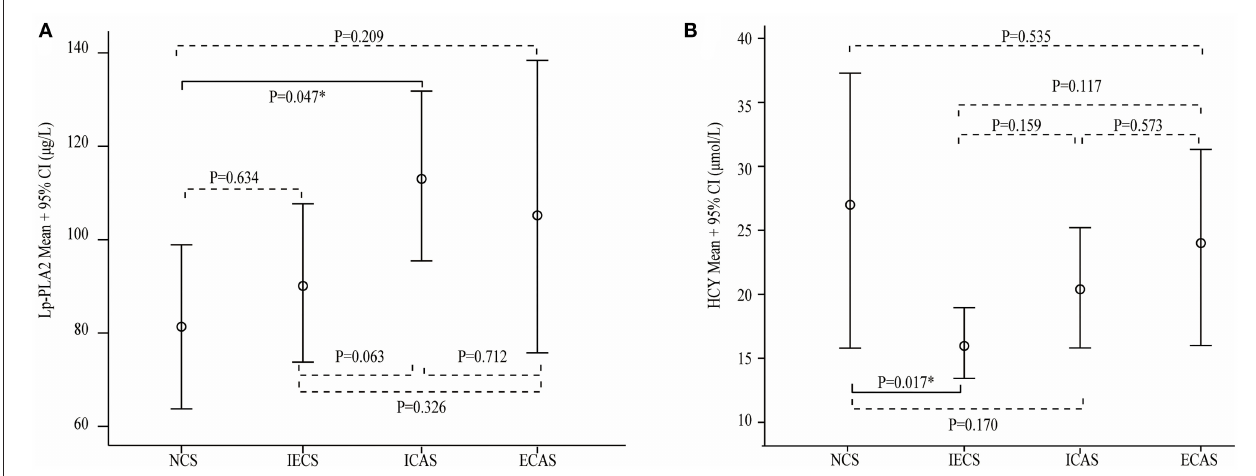
FIGURE 1 | Serum lipoprotein-associated phospholipase A2 (Lp-PLA2) (A) and homocysteine (HCY) (B) levels in different stenosis subtypes. Lp-PLA2 levels were higher in the intracranial artery stenosis (ICAS) group than that in the other three groups, and the difference between the no cerebral artery stenosis (NCS) and ICAS groups was statistically significant (A) . The HCY level was significantly higher in the NCS group than in the intracranial and extracranial artery stenosis (IECS) group (B) .